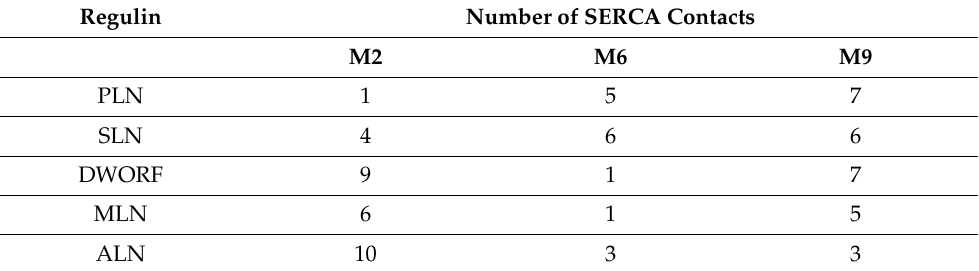
Table 2. Number of molecular contacts between the regulins and SERCA transmembrane segments M2, M6, and